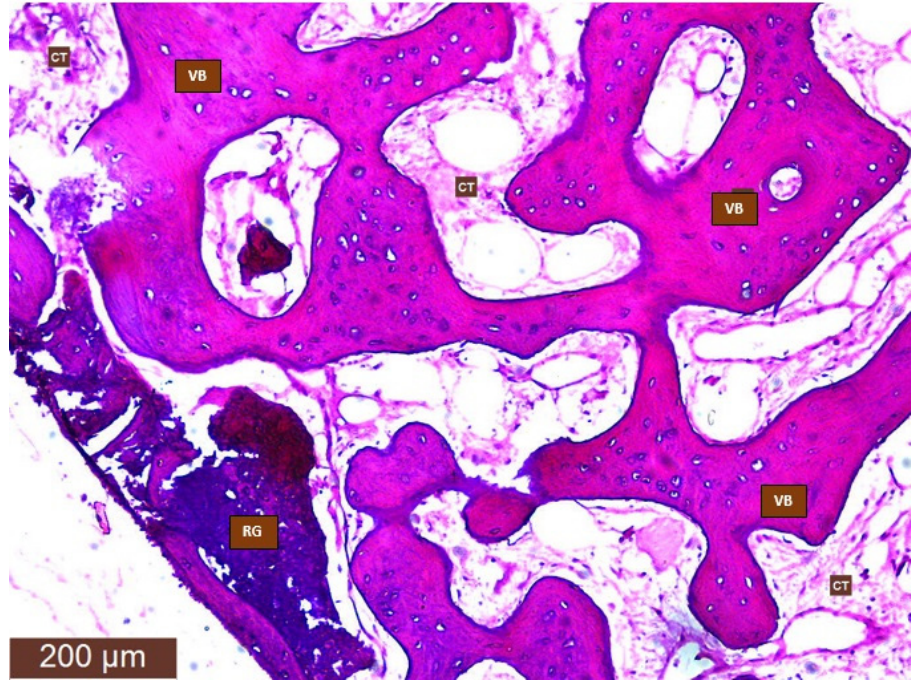
Figure 4 . Histological preparation of post-extraction socket four months after tooth extraction. (VB: vital bone; CT: connective tissue; RG: residual graft).